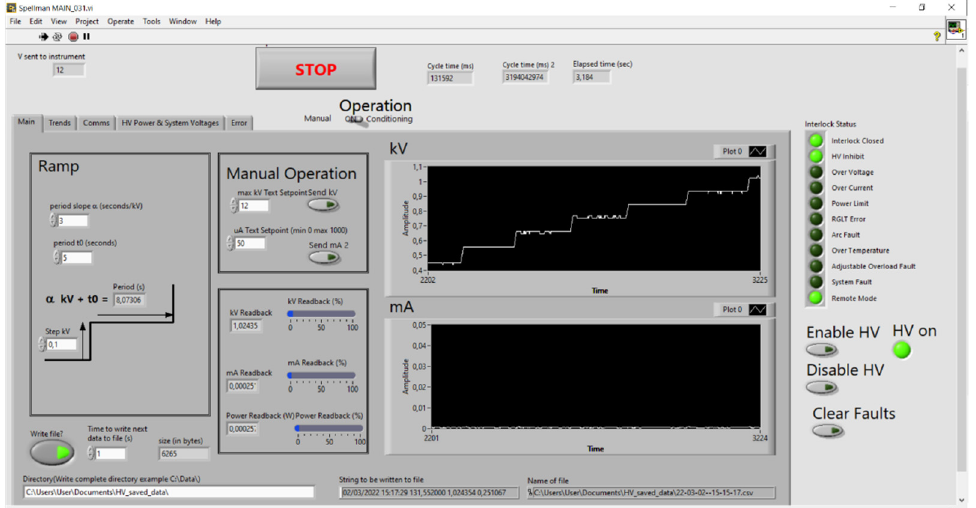
Figure 10. Interface of the LabView program: on the left there is the main menu to set the param- eters; on the right there is the trend of the voltage and the current values during the beginning of an